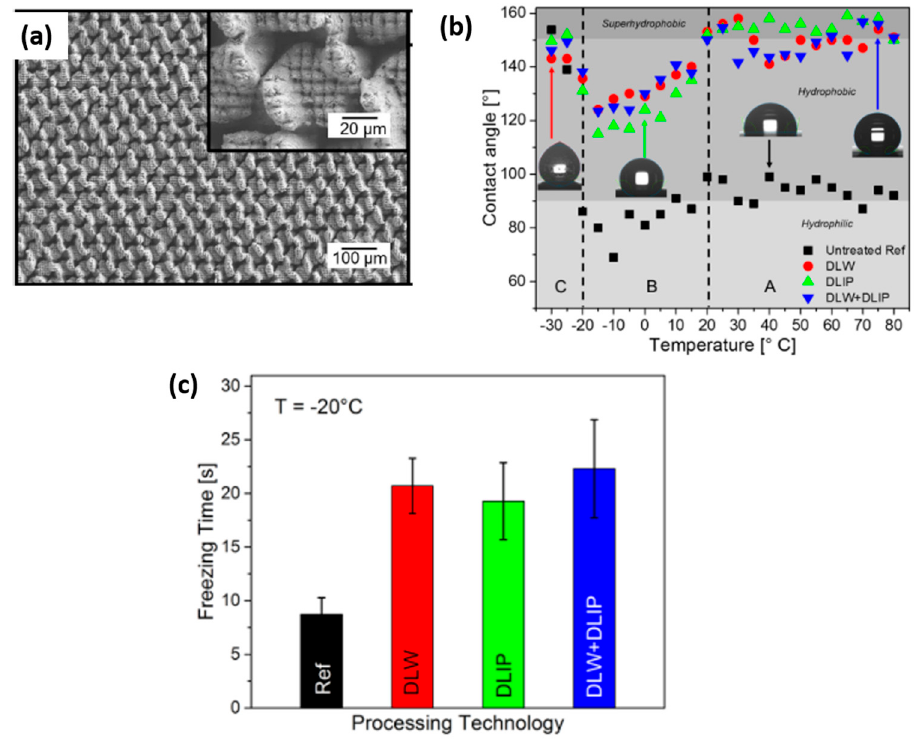
Figure 12. ( a ) Hierarchical microstructures, via DLW and DLIP techniques on pure aluminum. ( b ) Comparison between the contact angle of untreated reference, DLW, DLIP, and DLW + DLIP textured samples. The inserted images represent the droplets providing the measured angles depending on the temperature. ( c ) Average freezing time on an untreated reference, DLW, DLIP, and DLW + DLIP structures at − 20 ◦ C. The experiments were performed using 8 µ L of deionized water (From [124] under http: // creativecommons.org / licenses / by / 4.0 /